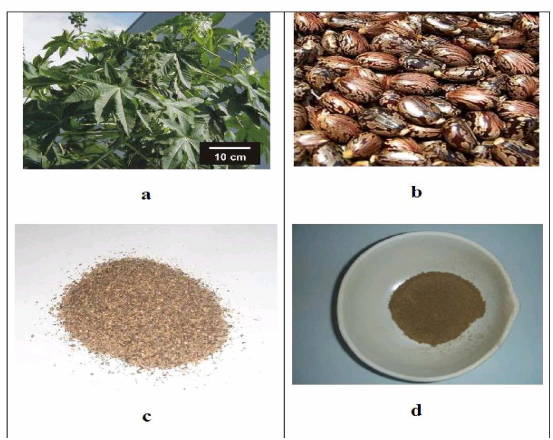
Figure 1. ( a ) Castor plant; ( b ) Castor beans; ( c ) Castor bean cake after extraction of oil; ( d ) Dry castor bean cake after grinding in a vibratory